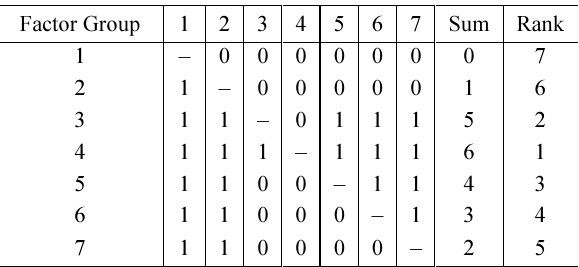
Table 1. Pairwise comparison of the main factor groups by one